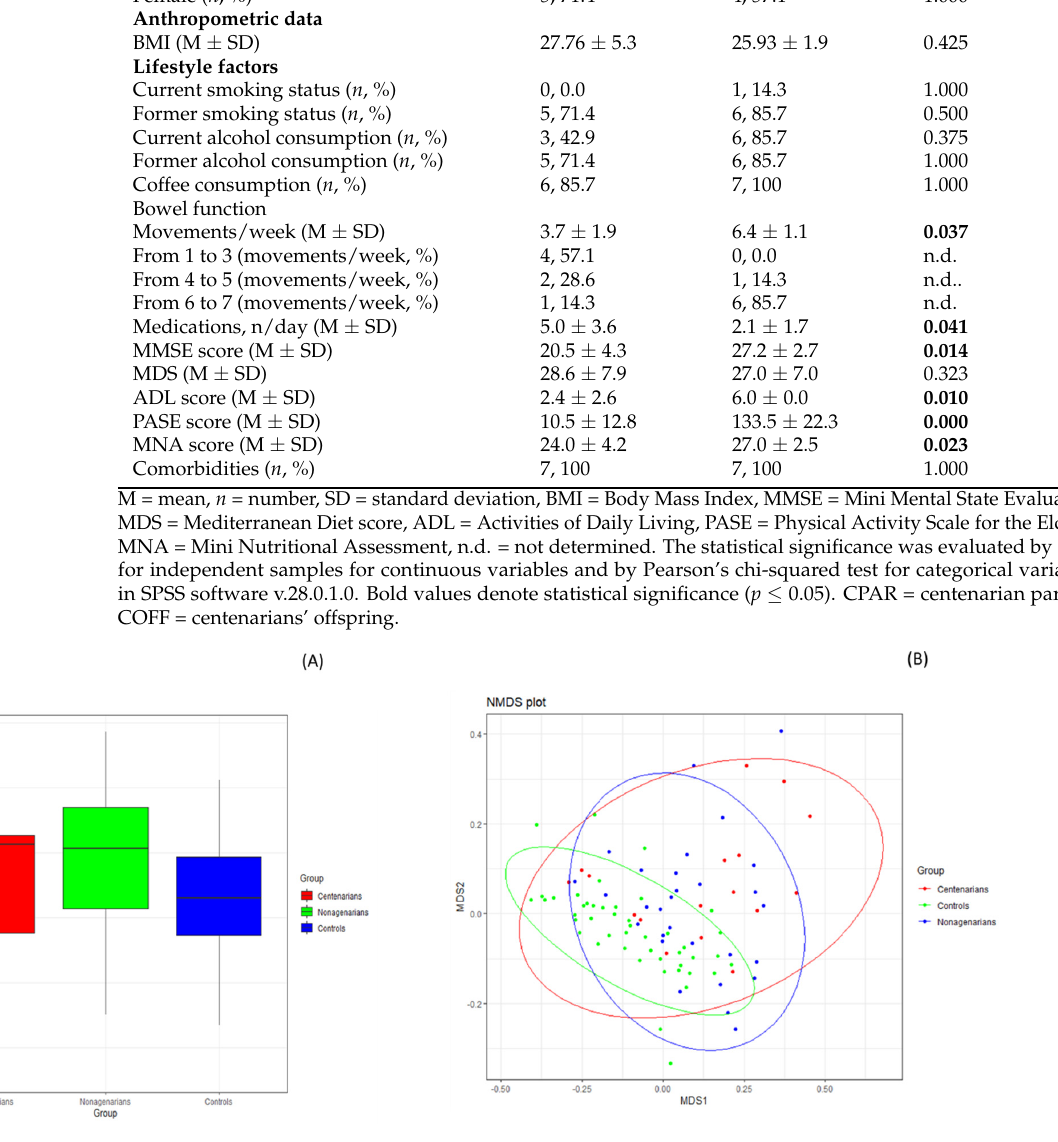
Figure 1. GM alpha and beta diversity analysis between CENT, NON and CTLs groups. ( A ) Plots indicate a statistically significant difference in the Shannon index between CENT and NON, evaluated by Kruskal ‐ Wallis test. p equal to or less than 0.05 was considered statistically significant. ( B ) The Non ‐ Metric Multidimensional Scaling (NMDS) plot based on Bray ‐ Curtis distance matrix, performed in R software v.3.5.2 (ggplot2 package), showed a marked separation between the GM communities of LLS groups and CTLs. The statistical significance among the groups was determined with Permutational Multivariate Analysis of Variance (PERMANOVA) performed in R ‐ vegan, function adonis (sum of square s = 1.498, mean of squares = 0.749, F = 6.074, R = 0.1201, p = 0.001). Significant segregation persisted only in the comparison between CENT and CTLs ( p = 0.006) and between NON and CTLs ( p = 0.003) following the pairwise PERMANOVA test performed in R (RVAdeMemoire package). p ≤ 0.05 was considered statistically significant. CENT = centenarian subjects, NON = nonagenarian subjects, CTLs = healthy younger controls, MDS = Multidimensional Scaling.